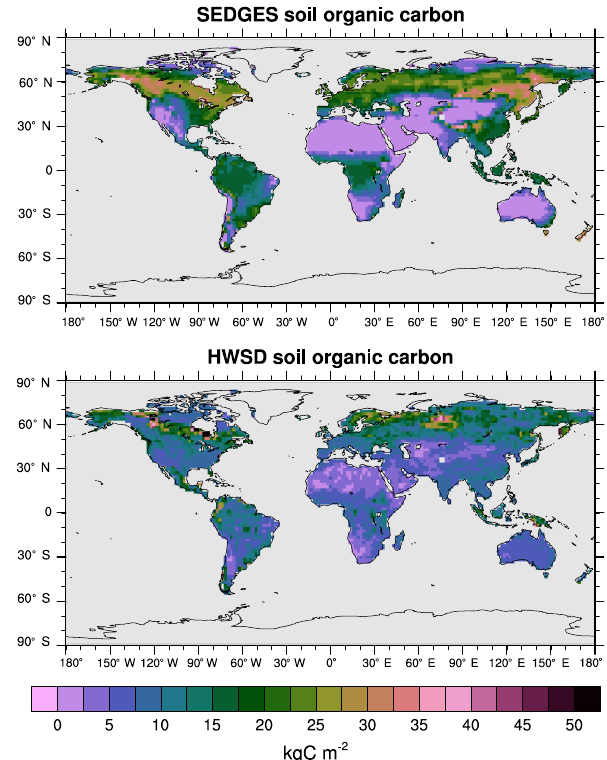
Figure 12. Soil organic carbon for SEDGES: mean over 1981– 2010 of the transient CO 2 simulation; soil organic carbon from the HWSD reference dataset (Wieder et al., 2011). The HWSD dataset has values for the top meter of the profile,